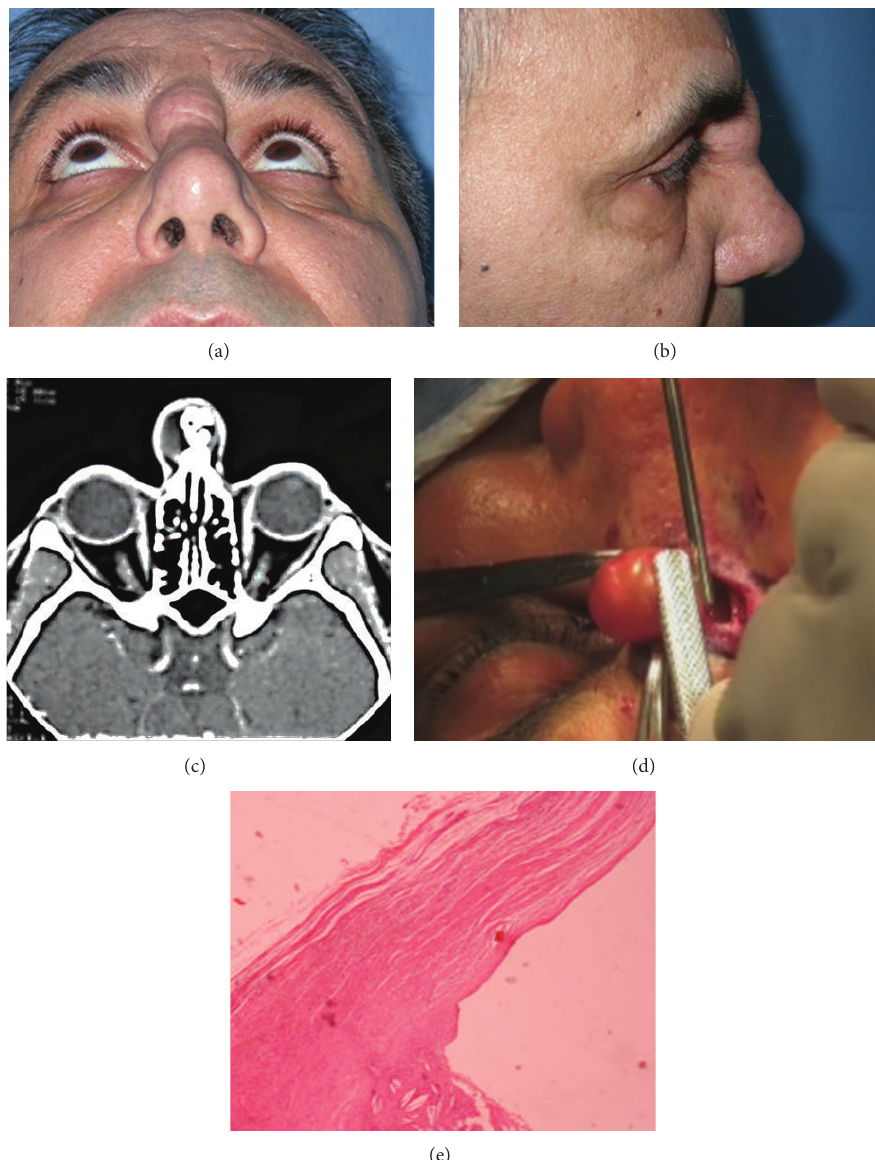
Figure 1: (a) Frontal view (Patient #1), (b) lateral view (Patient #1), (c) preoperative CT scan (Patient #1), (d) intraoperative view of nasal cyst removal (Patient #1), and (e) pathology specimen (Patient